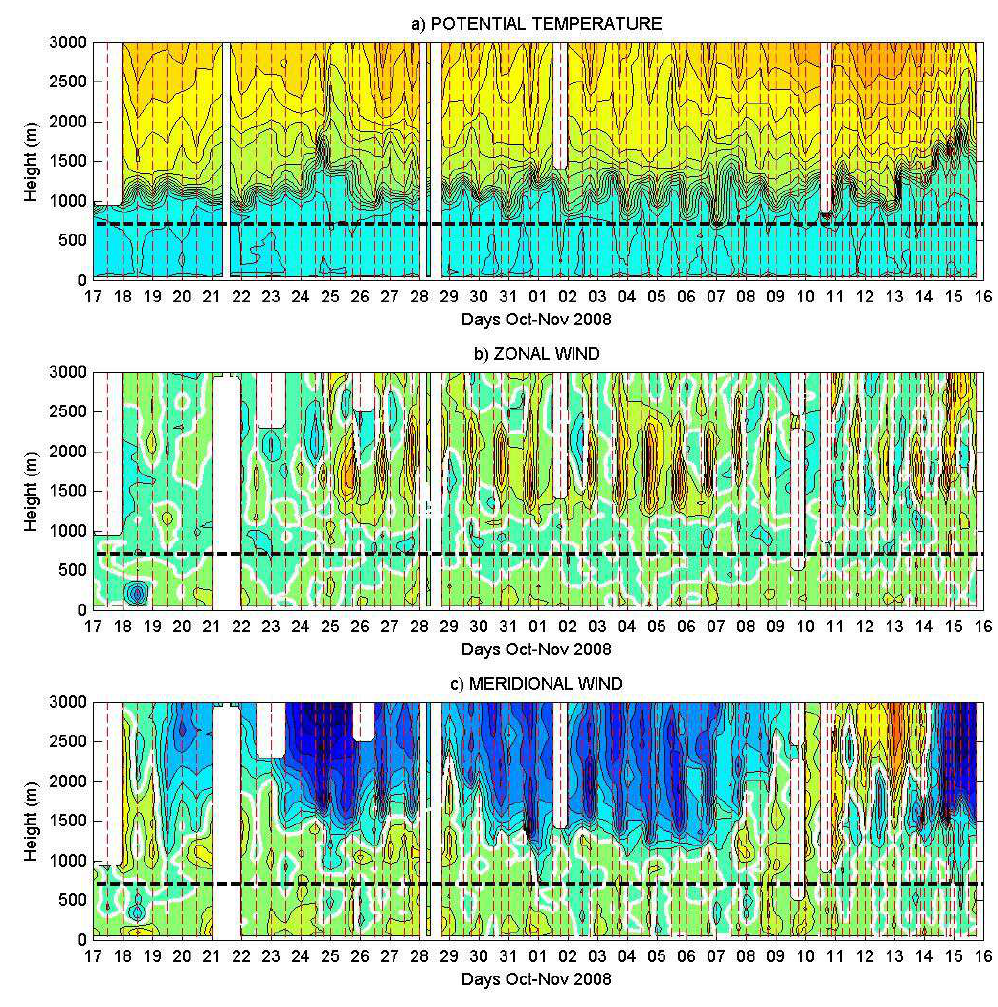
Fig. 5. Time–height cross sections of Paposo radiosonde observations during VOCAL-REx. (a) Potential temperature (contours every 2 ◦ K), (b) zonal wind component (contours every 2ms − 1 ; white contour is 0m s − 1 ) , (c) as (b) but for the meridional wind component. Horizontal black dashed lines mark the altitude of PA. Vertical red dashed lines mark times of available radiosonde launchings.